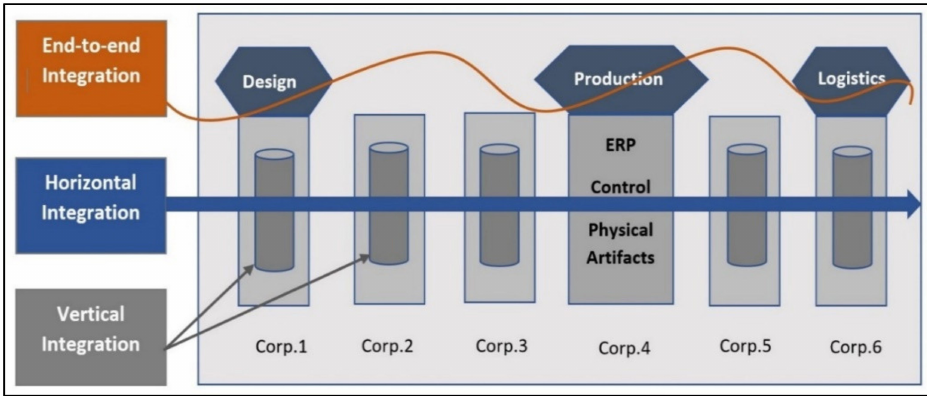
Figure 1. Three kinds of integration and their relationship, adopted from [17].